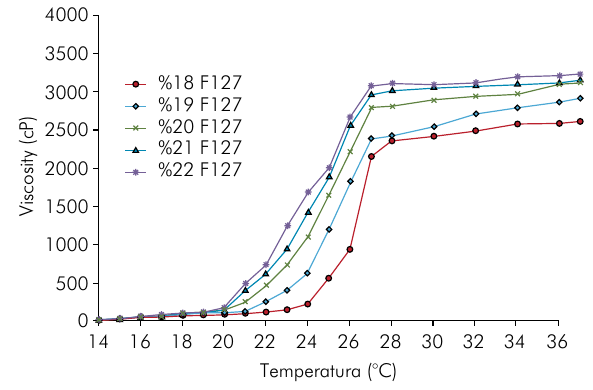
Figure 2. The viscosity of poloxamer hydrogels prepared with different polymer concentrations of between 18% and 22% at different temperatures. p < 0.05 was considered as significant.